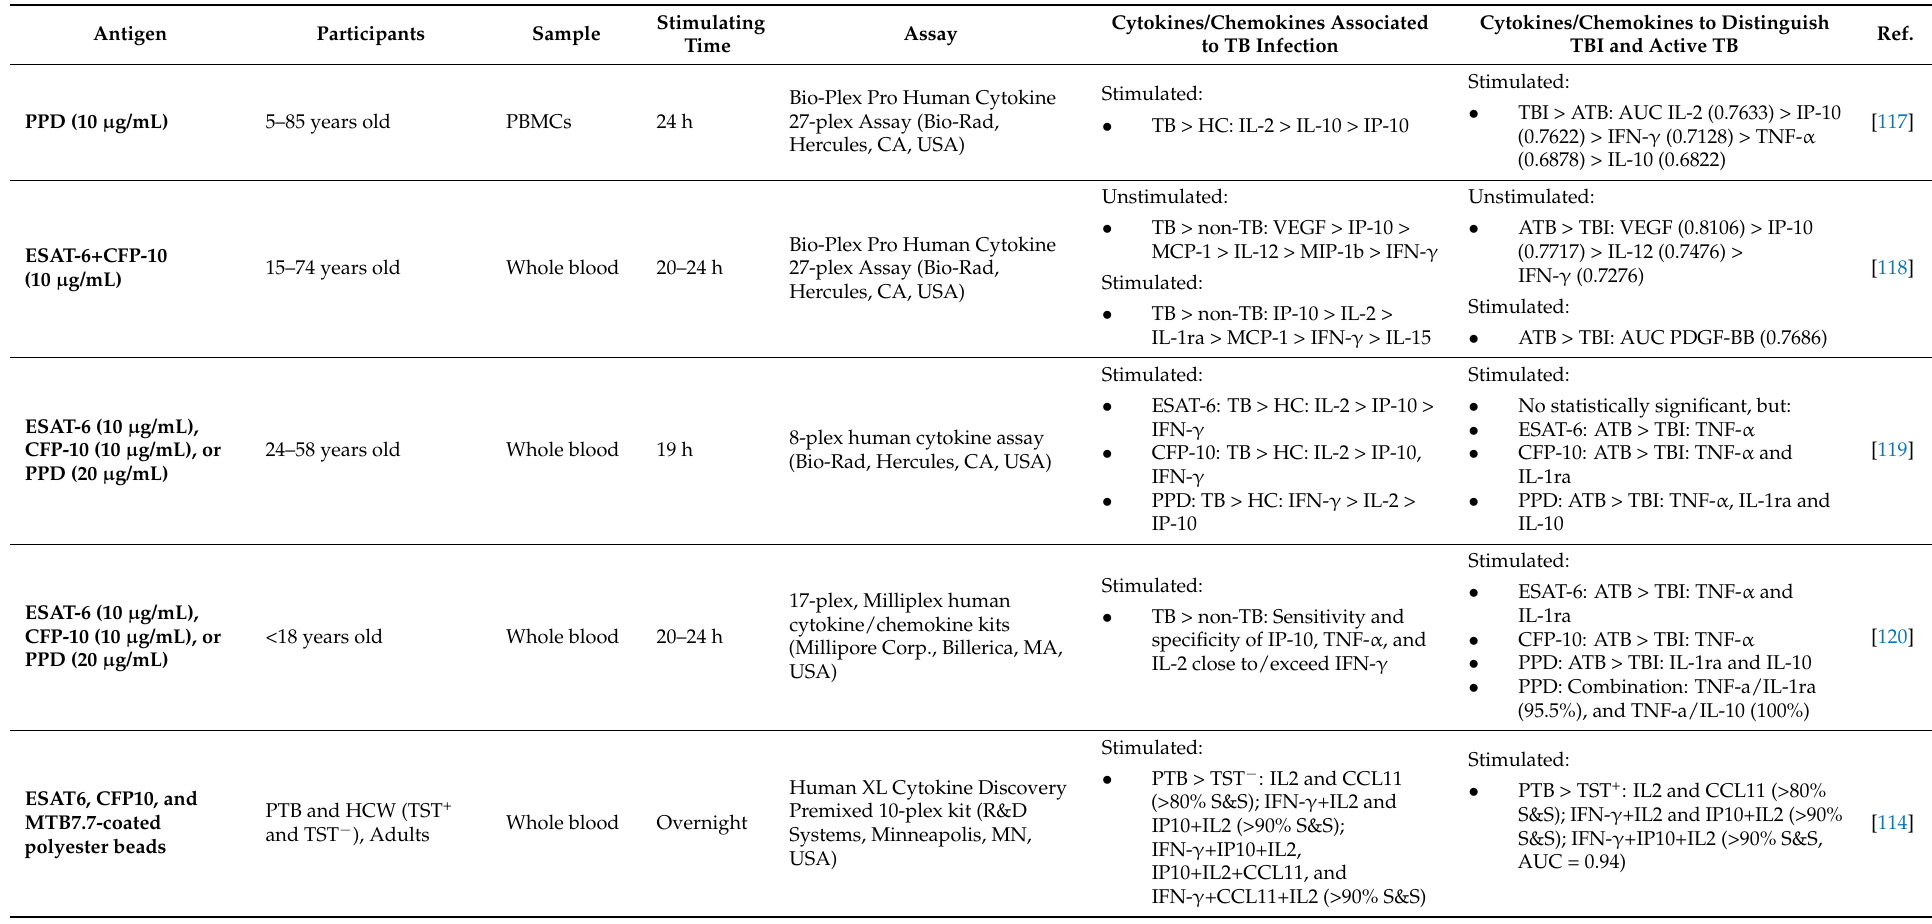
Table 3. Cytokines associated with TB